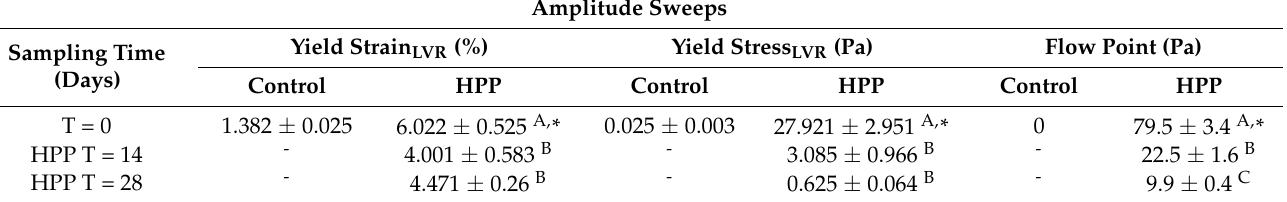
Table 1. Viscoelastic parameters obtained from amplitude sweep tests (yield strain, yield stress and flow point).